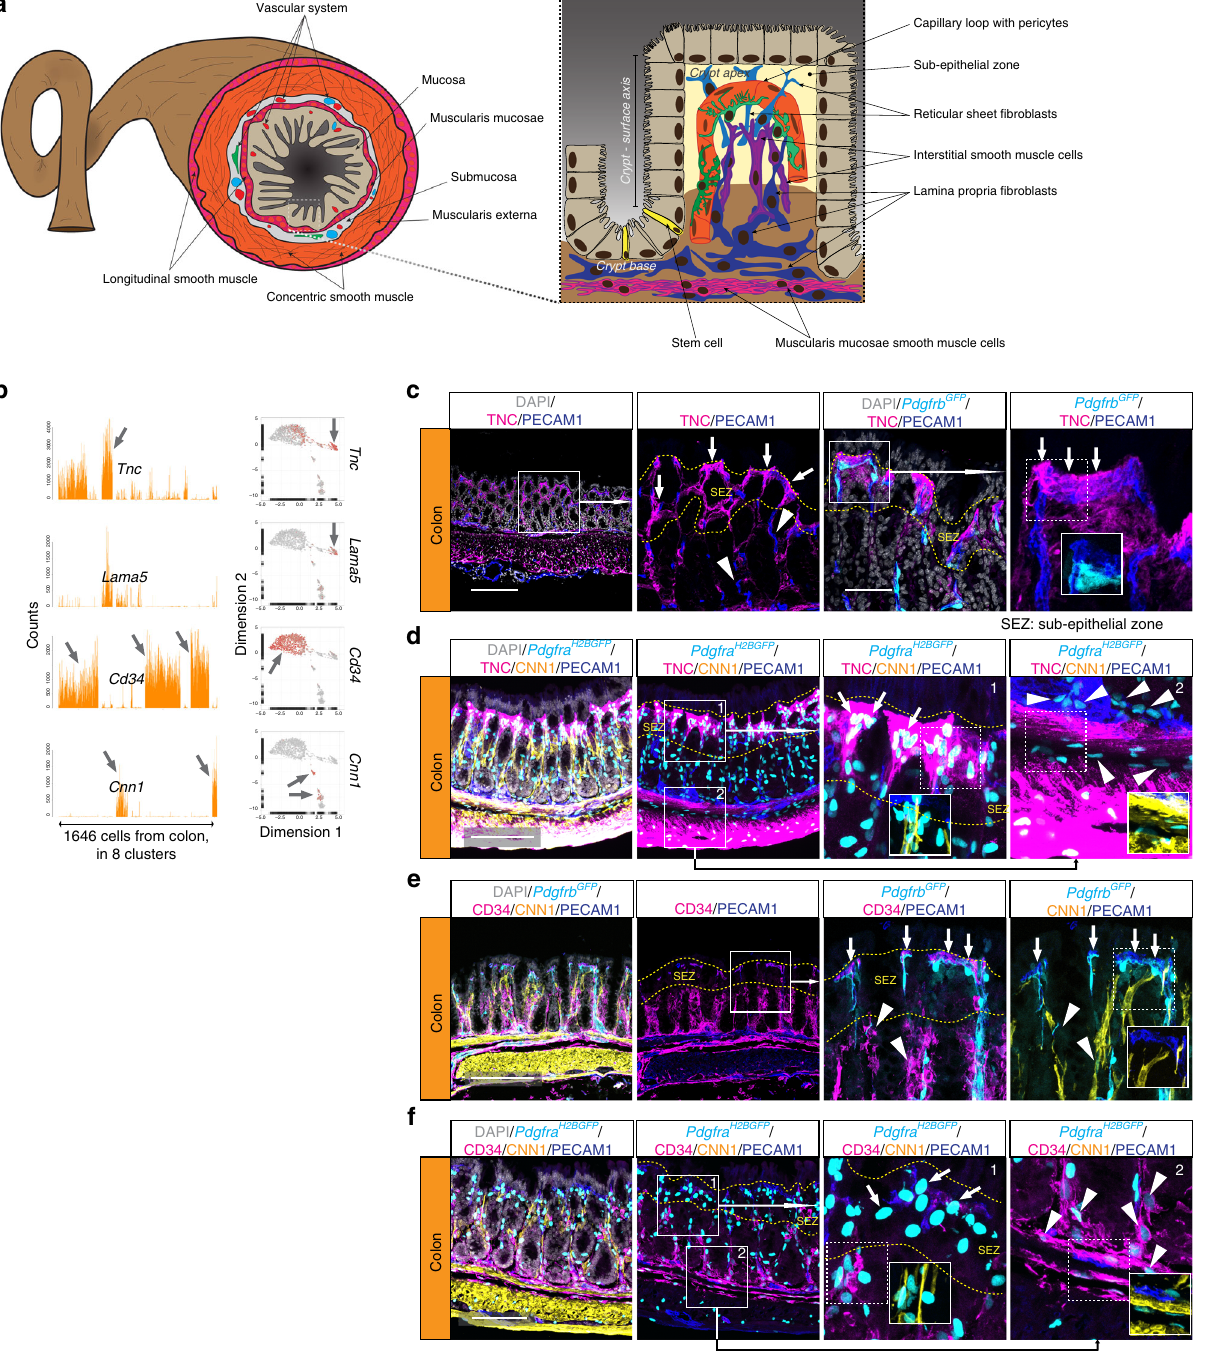
Fig. 5 Fibroblast subtypes in the colon. a Schematic depiction of colon anatomy. b Bar plots and UMAP visualization (gray, low; red, high expression) showing examples of genes with cell subtype-speci fi c expression (arrow). c – f Immuno fl uorescence staining of colon samples from reporter lines Pdgfrb GFP ( c , e ) and Pdgfra H2bGFP ( d , f ) for indicated markers; c , d TNC + cells close to the crypt apex surface (arrows); e , f CD34 + cells at the crypt base (arrowheads); d , f Pdgfra + cells close to the crypt apex surface, negative for CD34 or CNN1 (arrows). Arrowheads: Pdgfra + CD34 + cells at crypt base and muscularis mucosae, negative for CNN1. Scale bar: c , e 200 µ m, d , f 100 µ